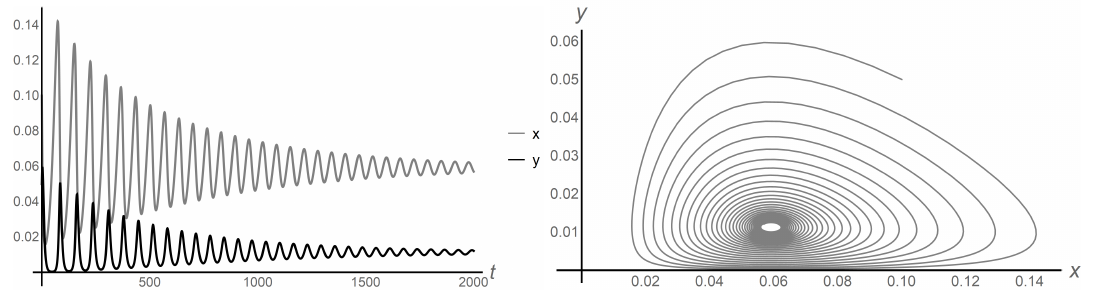
Figure 3. Trajectories of the prey and predator populations from model (1) towards the internal equilibrium E ∗ (0.0591, 0.0113) ( left panel ) along with the corresponding phase plane portrait ( right panel ). Parameter values: r = 0.16, α = 0.5; all the other values as in Table